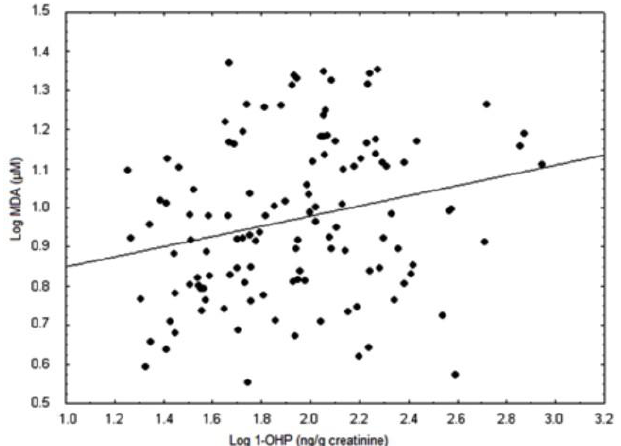
Figure 3. Association of plasmatic malondialdehyde (MDA) vs. urinary 1-hydroxypyrene (1-OHP) levels in non-smoker subjects, ( r = 0.426; p = 0.01; n =